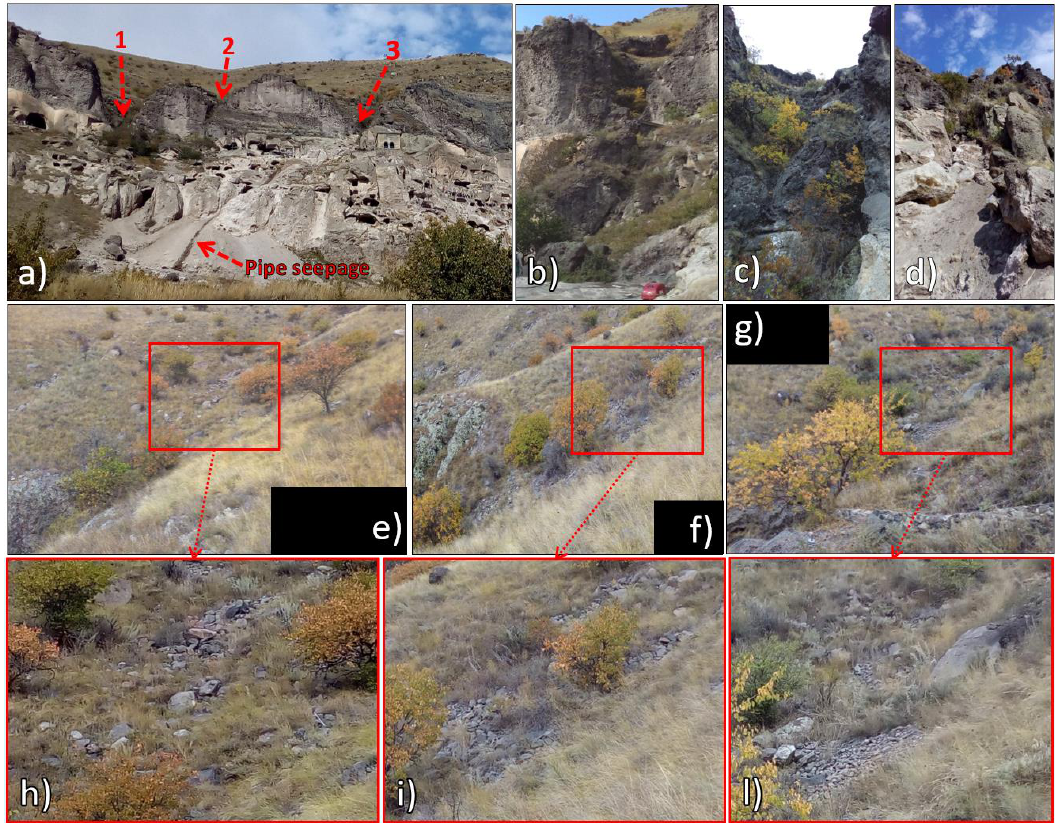
Figure 13. Field evidence of water erosion-sediment transport: ( a ) bottom view of the main streams (1-2-3), rock slope cuts of the Stream 1 ( b ), 2 ( c ) and 3 ( d ), view of the erosional–transport features in the slope brake between upper slope and cliff face Stream 1 ( e – h ), 2 ( f – i ) and 3 ( g – l ).